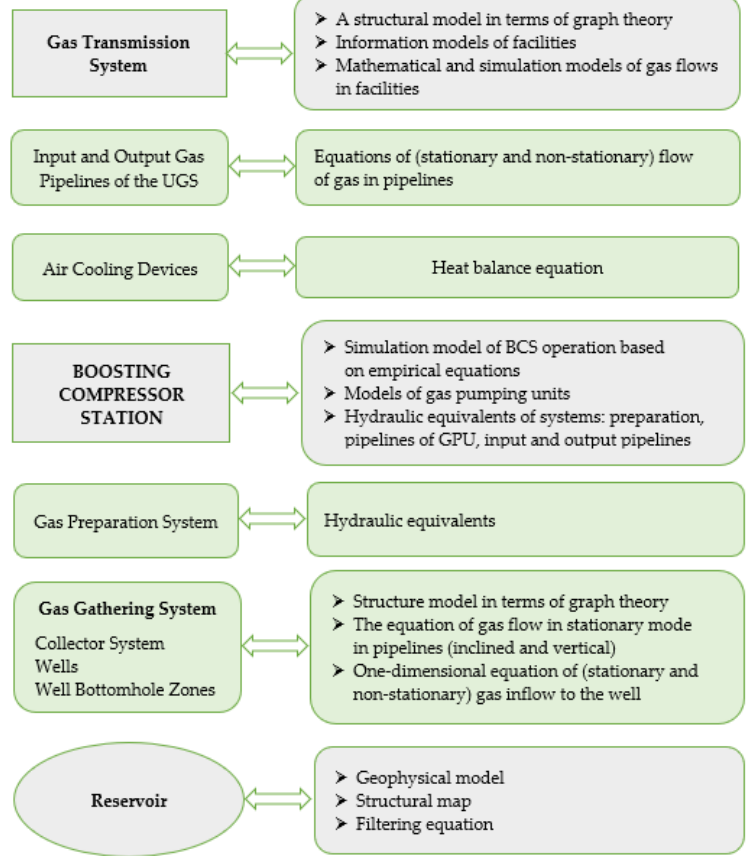
Figure 2. Generalized structure of the underground gas storage model.